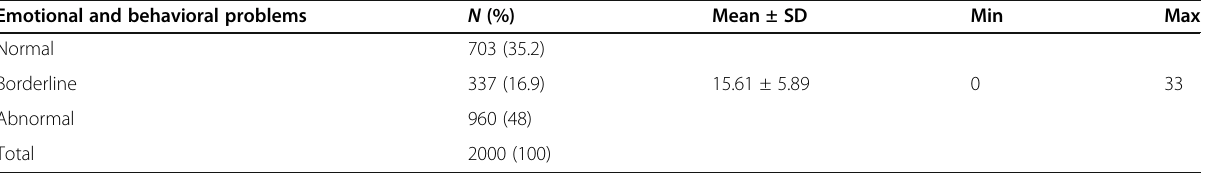
Table 2 Distribution of emotional and behavioral problems in the student city of Shiraz Emotional and behavioral problems